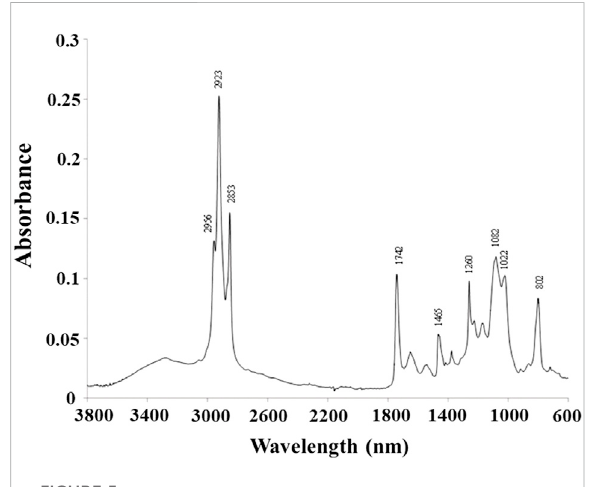
FIGURE 5 FTIR spectra of P(3HB-co-3HHx-co-3HO-co-3HD-co- 3HDD) extracted from the Pseudomonas sp. GL06 cells at 48 h cultured in the